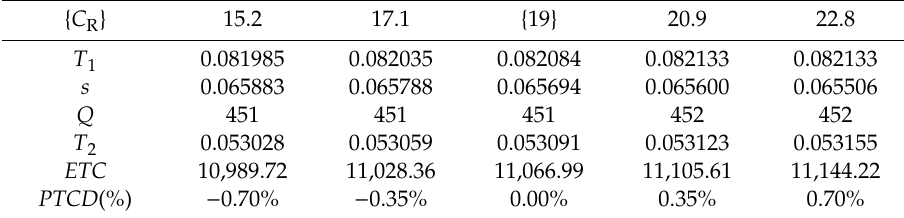
Table 12. Sensitivity analysis when the rework cost changes.